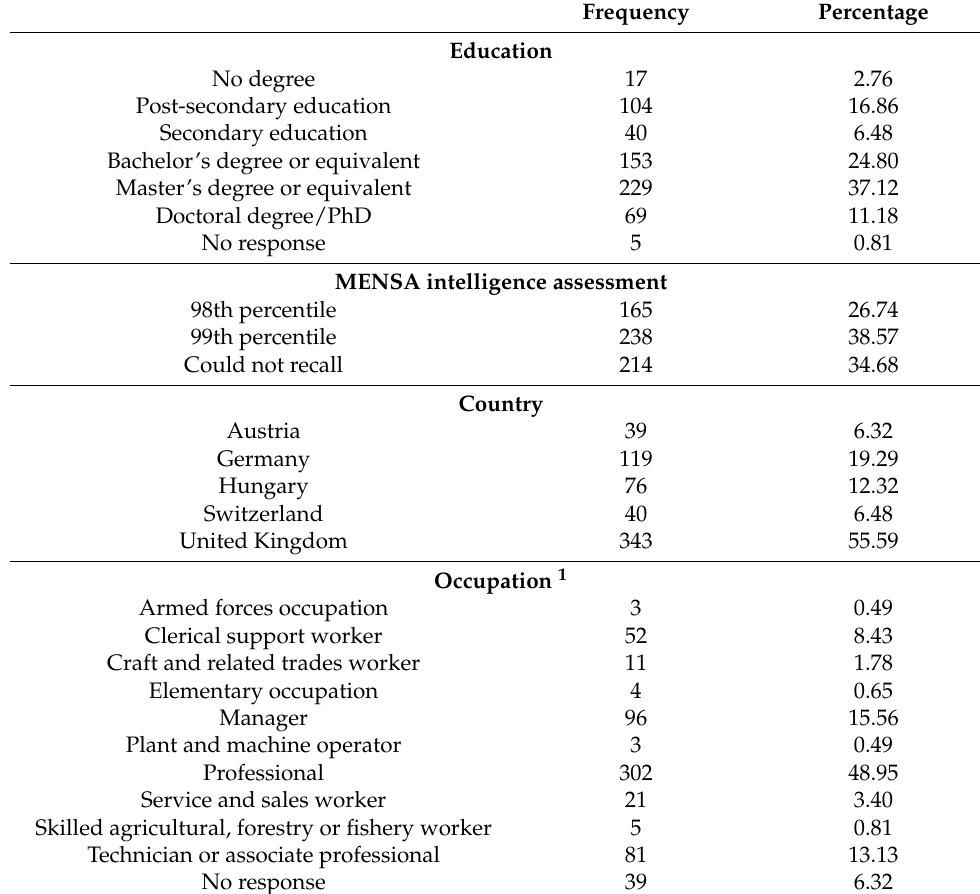
Table 3. Sociodemographic sample